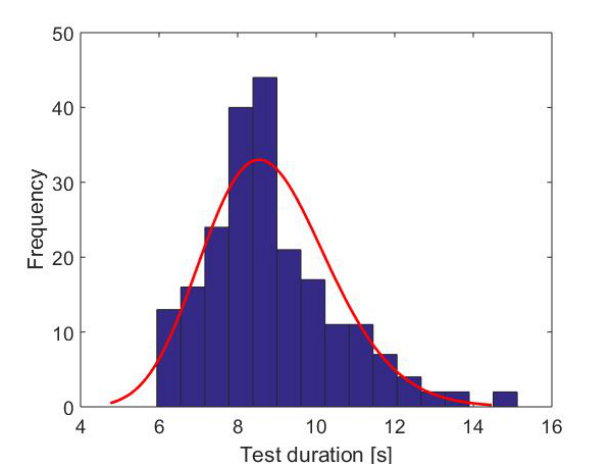
Figure 7. Distribution of the TUG test duration (stopwatch measurements) and the estimated gamma distribution (red